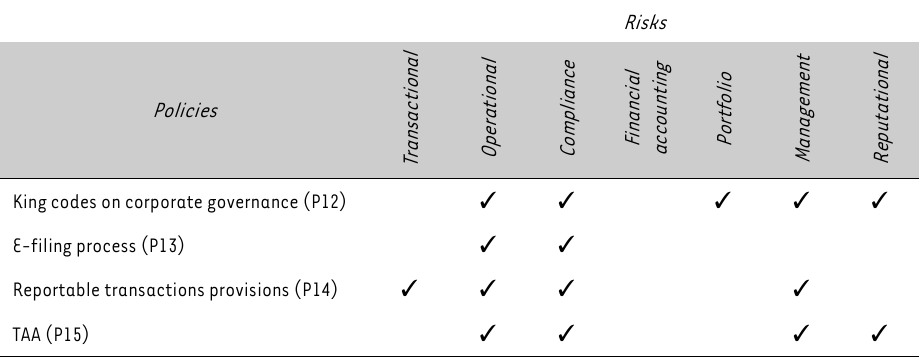
TABLE 3: TRM programmes in South Africa